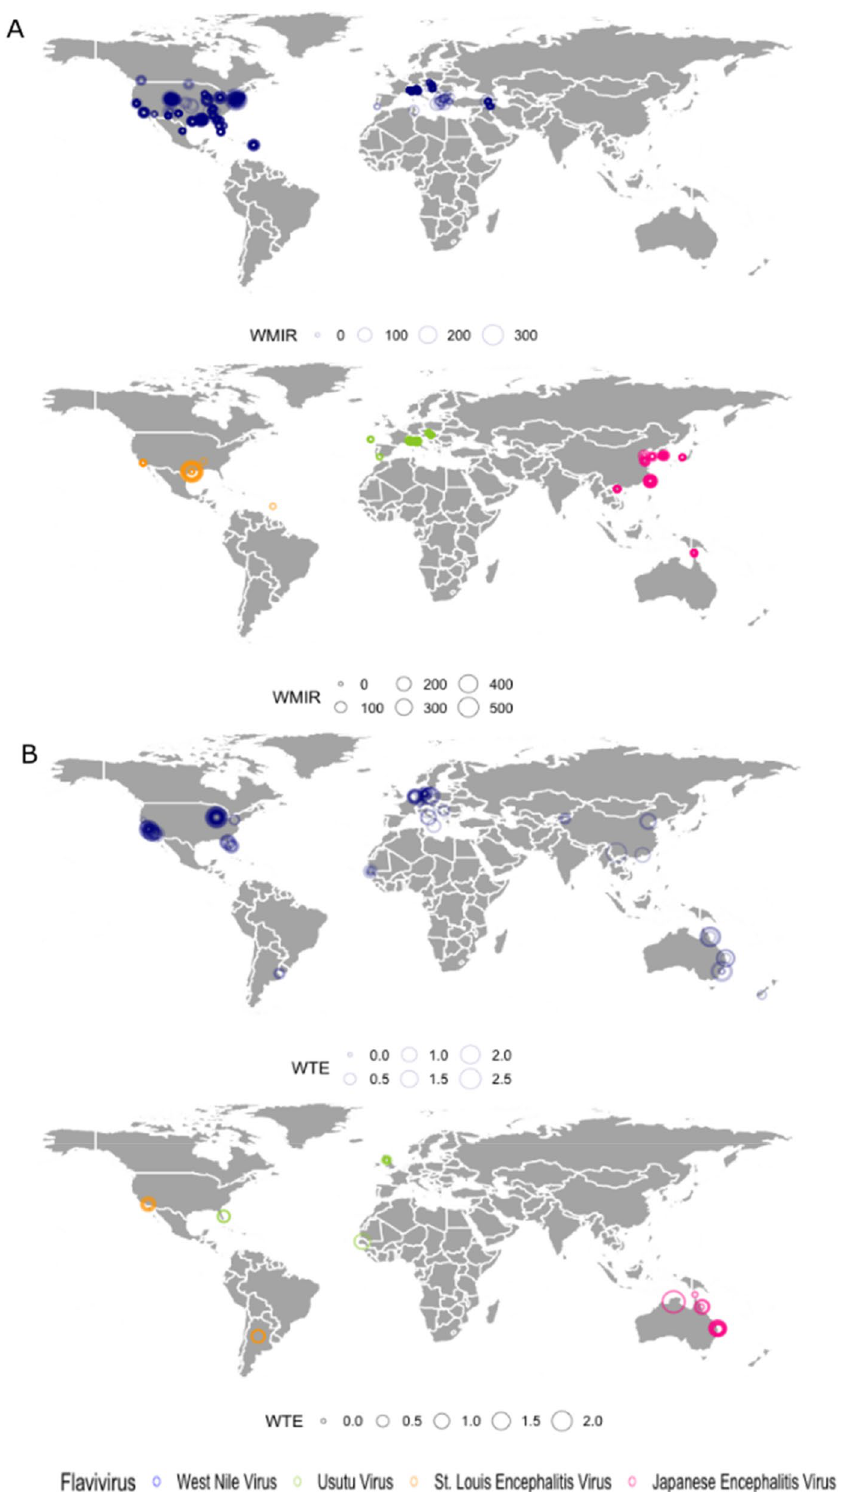
Figure 1. ( A ) Weighted Minimum Infection Rates and ( B ) Weighted Transmission Efficiency of mosquito populations for JES. High-quality data. The size of circles represents the magnitude of the estimates. Map was generated using R software version 4.1.2 with the packages mapdata, maps and tydiverse (https:// www.r- proje ct. org) and edited with Inkscape (https:// inksc ape. org/